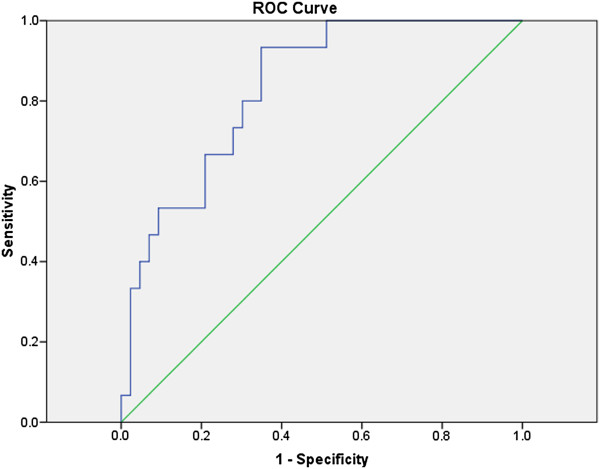
White cell count for diagnosis of AH. The area under the ROC curve is shown for the performance of the White Cell Count for discriminating AH from no AH diagnosis.